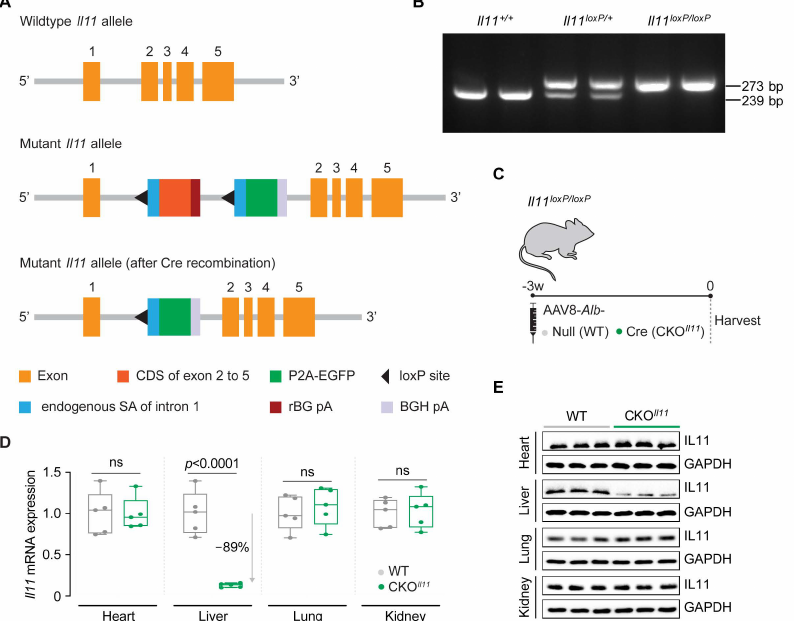
Figure 4. Generation and validation of hepatocyte-specific Il11 -deficient adult mice. ( A ) Schematic design showing the deletion of exons 2–5 of the mouse Il11 locus and the gene targeting strategy. ( B ) Representative genotyping of Il11 +/+ , Il11 loxP/+ , or Il11 loxP/loxP mice. ( C ) Schematic showing AAV8-induced hepatocyte-specific Il11 knockout mice (CKO Il11 ). ( D ) Il11 mRNA ( n = 5/group) and ( E ) IL11 protein ( n = 3/group) expression in the heart, liver, lung, and kidney from WT and CKO Il11 mice. ( D ) Data are shown in a box-and-whisker plot with median (middle line), 25th–75th percentiles (box), and minimum-maximum values (whiskers), with a 2-tailed Student’s t